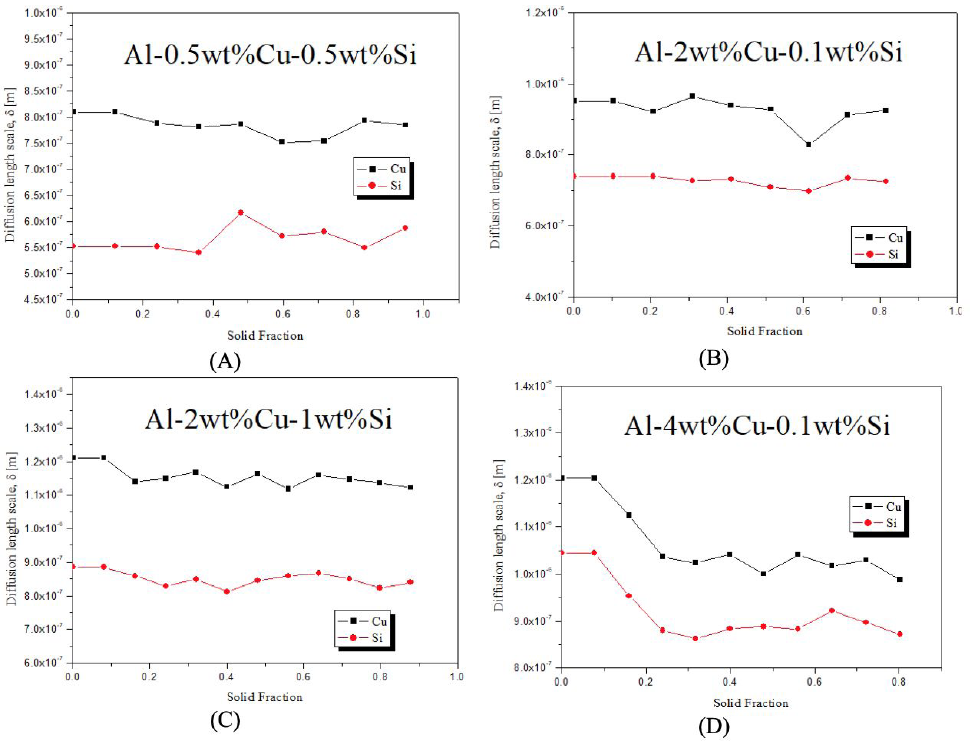
Figure 4. Diffusion length scale as a function of solid fraction for: (A) Al-0.5wt%Cu-0.5wt%Si, (B) Al-2.0wt%Cu-0.1wt%Si, (C) Al-2.0wt%Cu-1.0wt%Si, (D) Al-4.0wt%Cu-0.1wt%Si alloys.